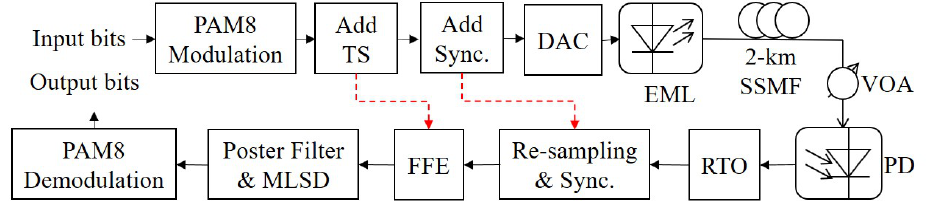
Figure 2. Block diagram of 129-Gbit/s optical PAM8 system. TS, training samples; DAC, digital-to-analog converter; EML, electro-absorption modulator integrated laser; SSMF, standard single-mode fiber; VOA, variable optical attenuator; PD, photodiode; RTO, real-time oscilloscope; Sync,